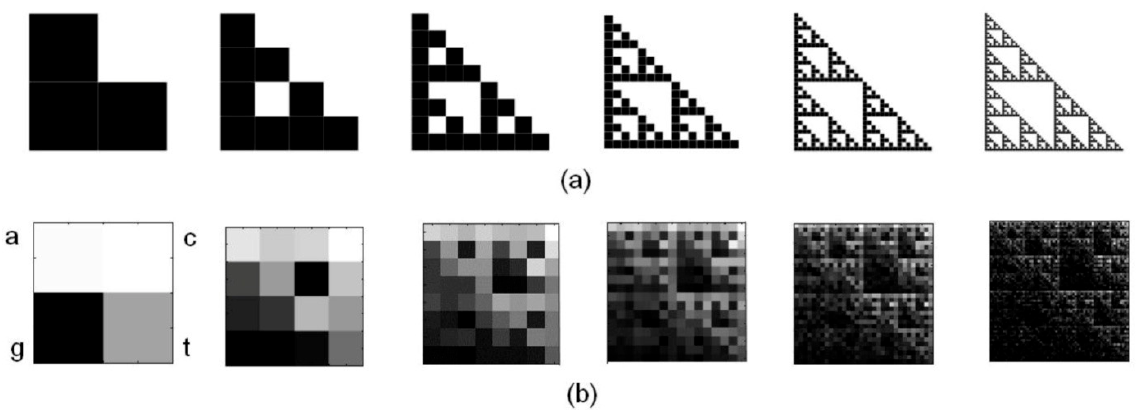
Figure 3. Chaos Game Representation (CGR) of human mtDNA. ( a ) The Sierpinski triangle, an ideal fractal generated by repeated iterations starting from a square. ( b ) Sierpinski-like self-similarity of mtDNA by CGR matrices 2 L × 2 L , for L = 1, 2 . . . , 6, of revised Cambridge Reference Sequence (rCRS).